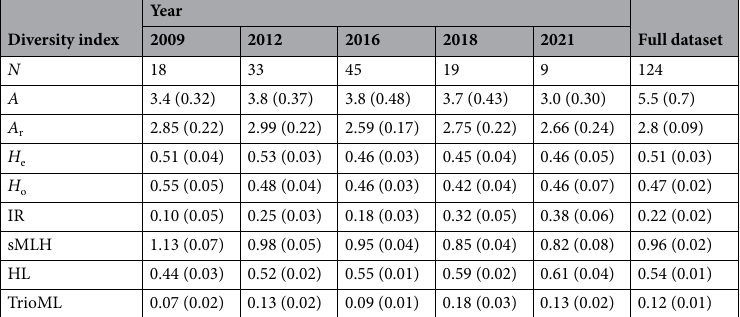
Table 1. Mean values and standard errors (in parentheses) of genetic diversity estimates for the captive peninsular pronghorn based on 16 microsatellite loci. Genetic diversity was evaluated for the complete dataset of 124 individuals as well as separately for each year. N = number of individuals, A = number of alleles, A r = allele richness, H e = expected heterozygosity, H o = observed heterozygosity, IR = internal relatedness, sMLH = standardized multilocus heterozygosity, HL = homozygosity weighted by locus, and TrioML = inbreeding index. A , A r , H e and H o were estimated by locus, whereas sMLH, HL, IR and TrioML are individual based